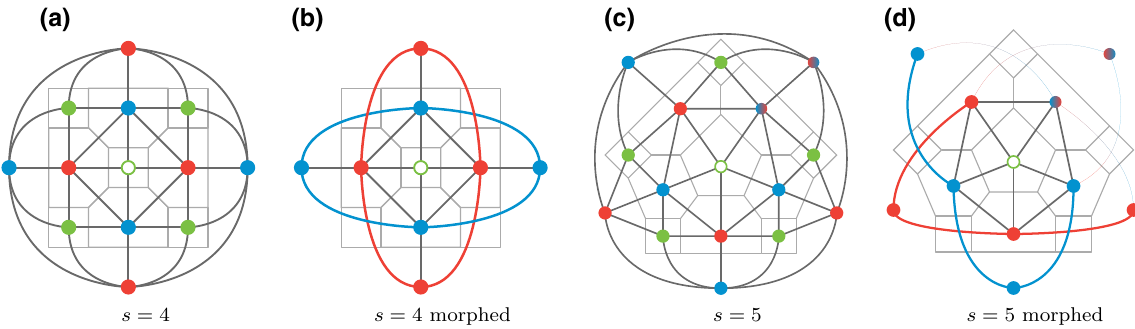
FIG. 17. Morphing stellated color codes. We show the (a) s = 4 and (c) s = 5 distance-3 stellated color codes, which have parameters [[20,4,3]] and [[25,5,3]], respectively. We show the primal lattice in light gray for ease of comparison with Ref. [89]. (b),(d) The corresponding morphed codes, with parameters [[12,4,2]] and [[15,5,2]]. We note that the central vertex has no associated stabilizer, which we indicate by making it hollow. For odd s , the color-code colorability condition is unsatisfied, indicating the presence of a twist defect. We represent this pictorially by blended r / b vertices and